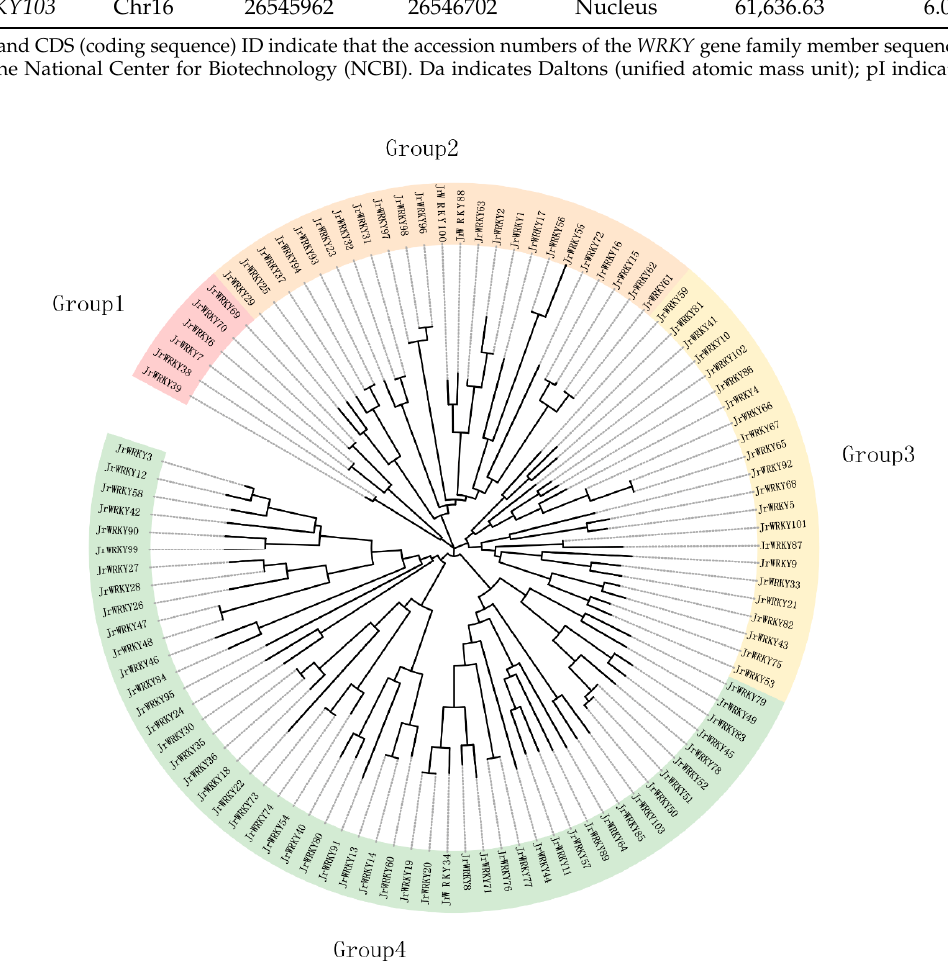
Figure 1. The phylogenetic tree of WRKY gene family in walnut based on the latest genome (NCBI ver- sion: GCA_001411555.2 Walnut 2.0). These 103 sequences were used to construct a neighbor-joining (NJ) tree. The tree was divided into four subfamilies; the names of different groups are